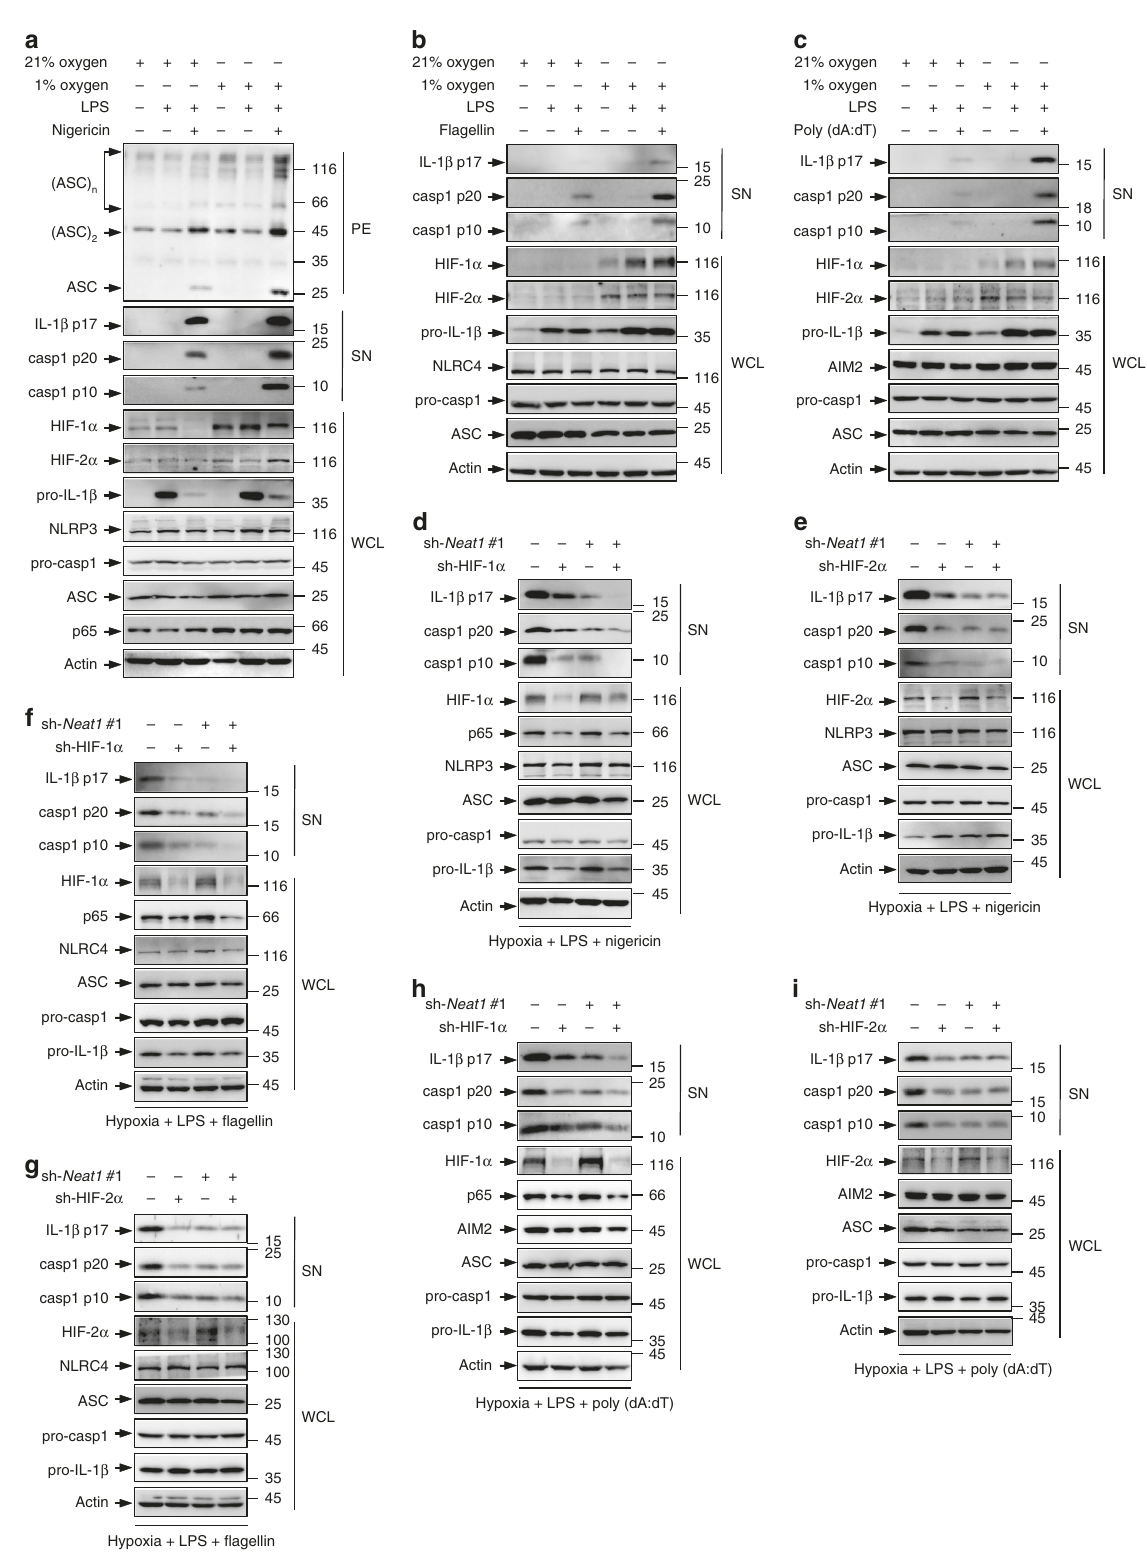
Fig. 9 Neat1 mediates the effect of HIF-2 α on in fl ammasomes under hypoxic condition. a – c iBMDMs cultured under normoxic or hypoxic conditions were untreated ( a – c ), primed with LPS ( a – c ,or co-stimulated with LPS and nigericin ( a ), fl agellin ( b ), or poly(dA:dT) ( c ). WCL ( a – c ), SN ( a – c ), and PE ( a ) were subjected to western blotting. d – i Control ( d – i ), HIF-1 α -silenced ( d , f , and h ), HIF-2 α -silenced ( e , g and i ), Neat1 -silenced ( d – i ), HIF-1 α - Neat1 -double- silenced ( d , f and h ), or HIF-2 α - Neat1 -double-silenced ( e , g and i ) iBMDMs were cultured under hypoxic conditions and primed with LPS, followed by stimulation with nigericin ( d , e ), fl agellin ( f , g ), or poly(dA:dT) ( h , i ). WCL and SN were analyzed by western blotting. Source data are provided as a